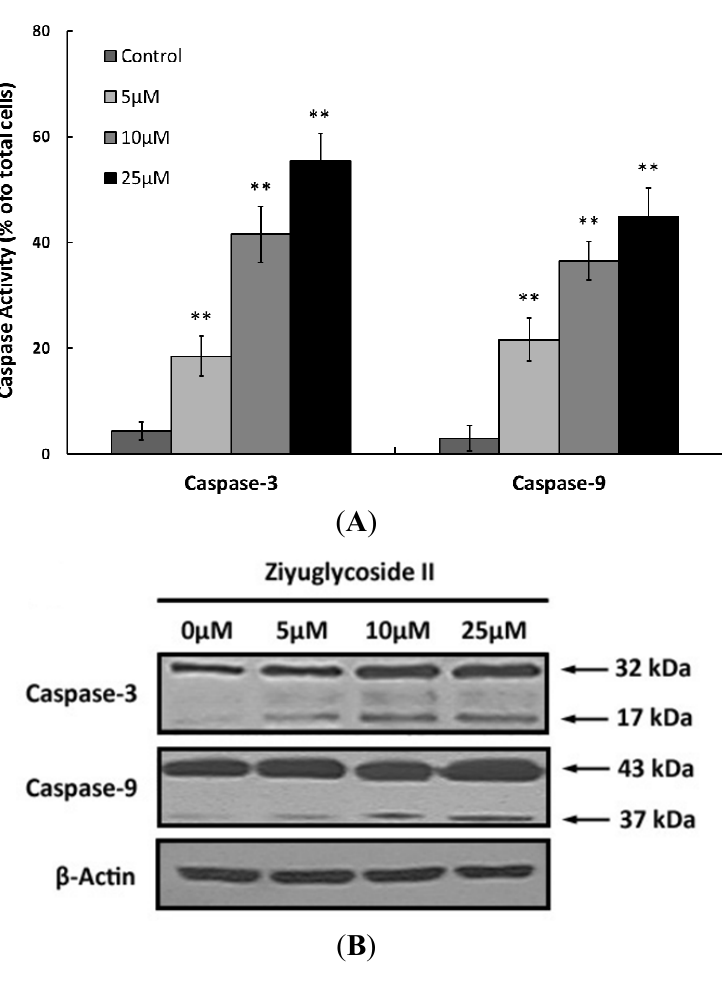
Figure 7. The effect of ziyuglycoside II on the activity and protein cleavage of caspase-3 and caspase-9. Cells were incubated with various concentrations of ziyuglycoside II for 24 h and then further analyzed for the activity and protein cleavage of caspase-3 and caspase-9. ( A ) The activity of caspase-3 and caspase-9 were determined as described in Materials and Methods. All data were expressed as mean ± SD of three experiments and each experiment included triplicate repeats. * p < 0.05, ** p < 0.01 vs. control; ( B ) The cleavage of caspase-3 and caspase-9 were assessed by western blot analysis. All data were representative of three independent